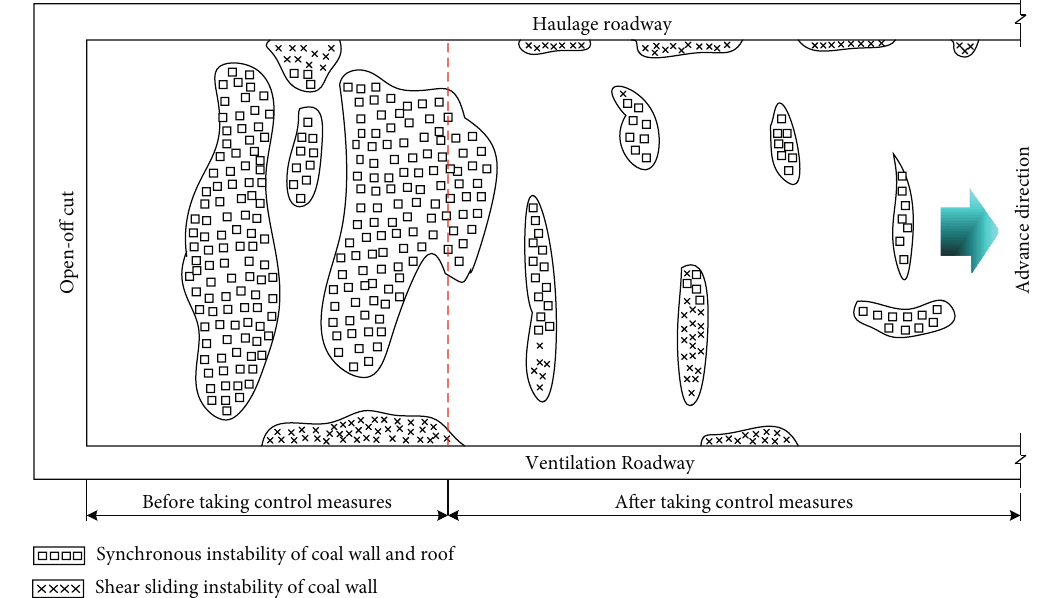
Figure 12: Comparison of working face control measures before and